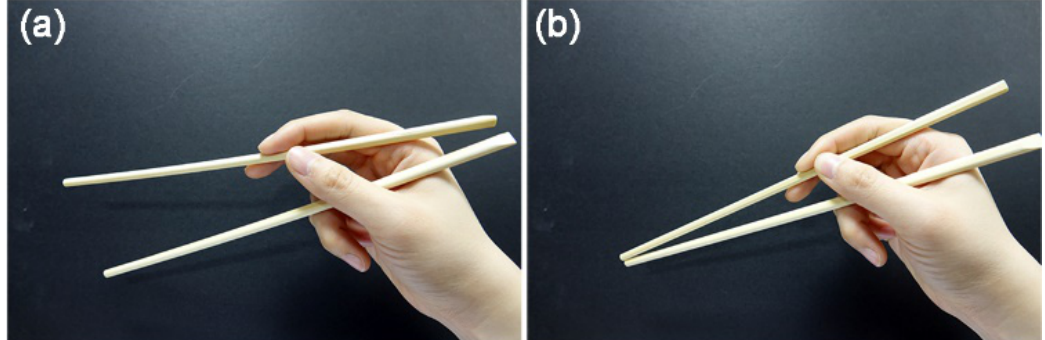
Figure 1. Photographs of moving chopsticks: ( a ) when the tips of the chopsticks are opened, and ( b ) when they are closed.